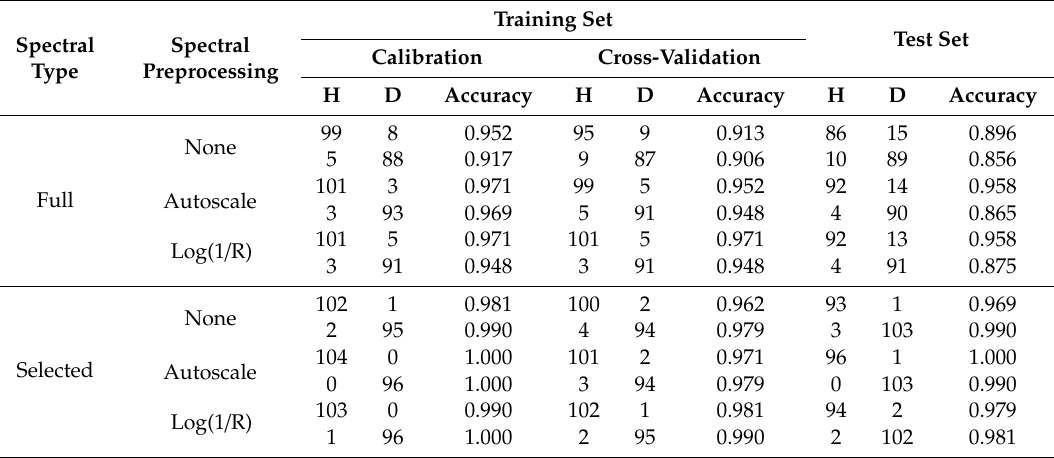
Table 2. Classification results for healthy and early disease blueberries by using partial least